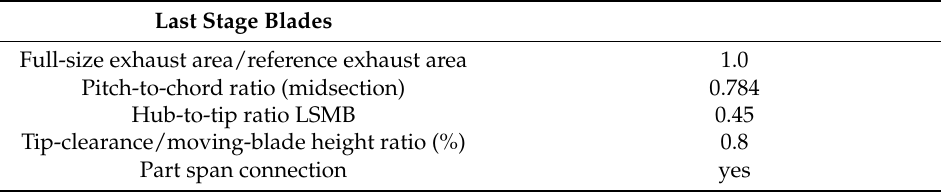
Table 2. Main last-stage design parameters for the reference exhaust area.